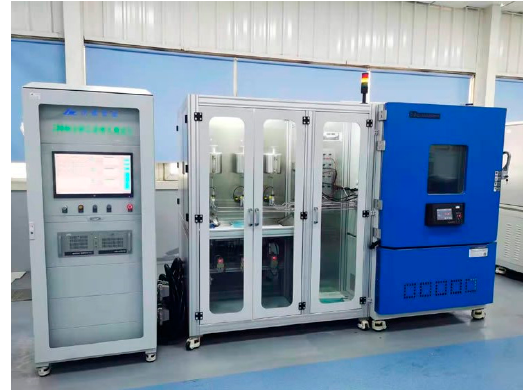
Table 4. Chemical composition of the simulated acid rain solution (mol/L).